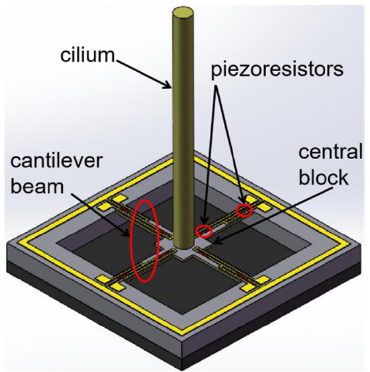
Figure 5. Schematic diagram of vector channel microstructure.